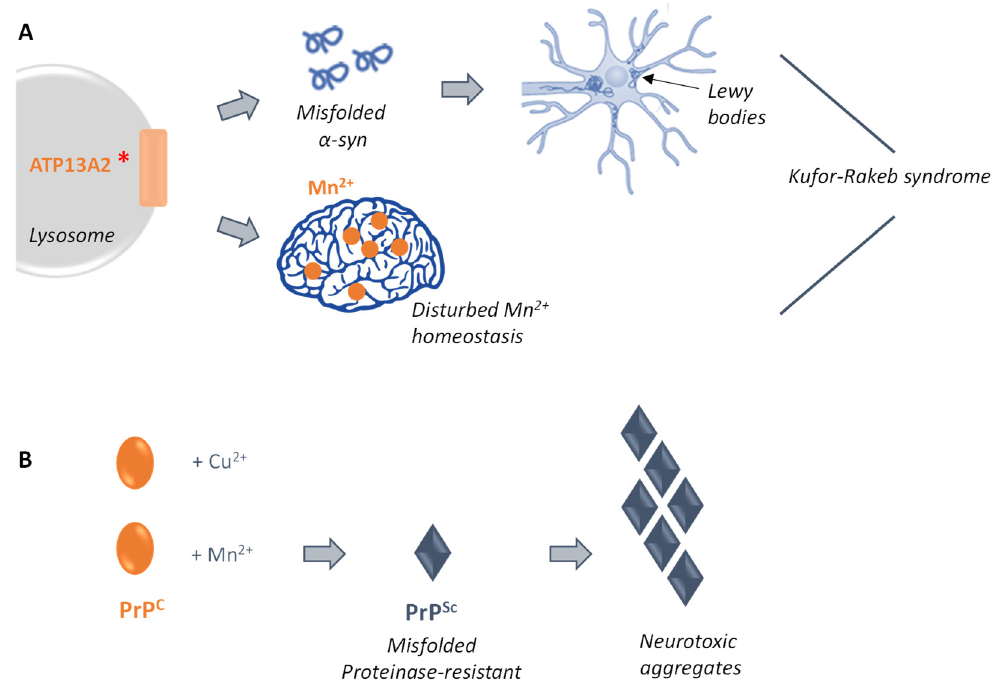
Figure 3. Mn 2 + -related molecular pathways associated with the development of two neurodegenerative diseases: the Kufor-Rakeb syndrome ( A ) and prion-related disorders ( B ). ( A ) Specific mutations within the human gene ATP13A2 have been shown to induce misfolding of the α -syn protein and its subsequent neurotoxic aggregation that leads to the formation of Lewy bodies in human neurons. In parallel, mutated ATP13A2 has been shown to directly disturb manganese homeostasis, thereby establishing a connection between genetics ( α -syn and ATP13A2) and environmental (unbalanced manganese exposure) causes of neurodegeneration. ( B ) The human protein PrP interacts, in its functional isoform (PrP C ), with copper, and also with manganese. This interaction with manganese has been suggested to induce the conversion of PrP C to its proteinase-resistant counterpart PrP Sc . In this form, PrP forms neurotoxic aggregates, thereby leading to the prion-disease associated symptoms.